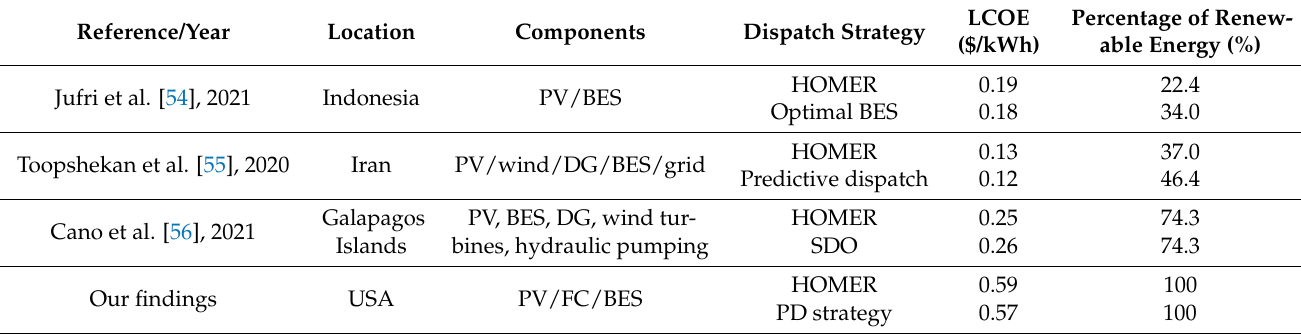
Table 7. Comparative analysis with the similar relevant study of recent